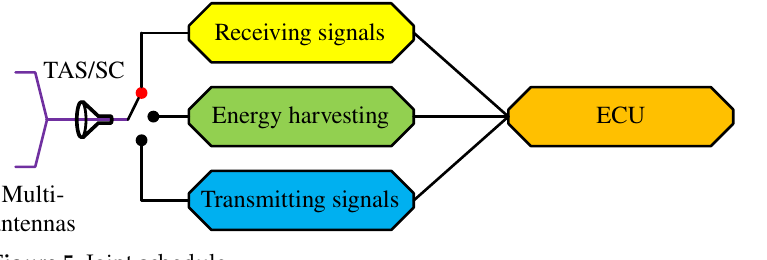
Figure 5. Joint schedule.